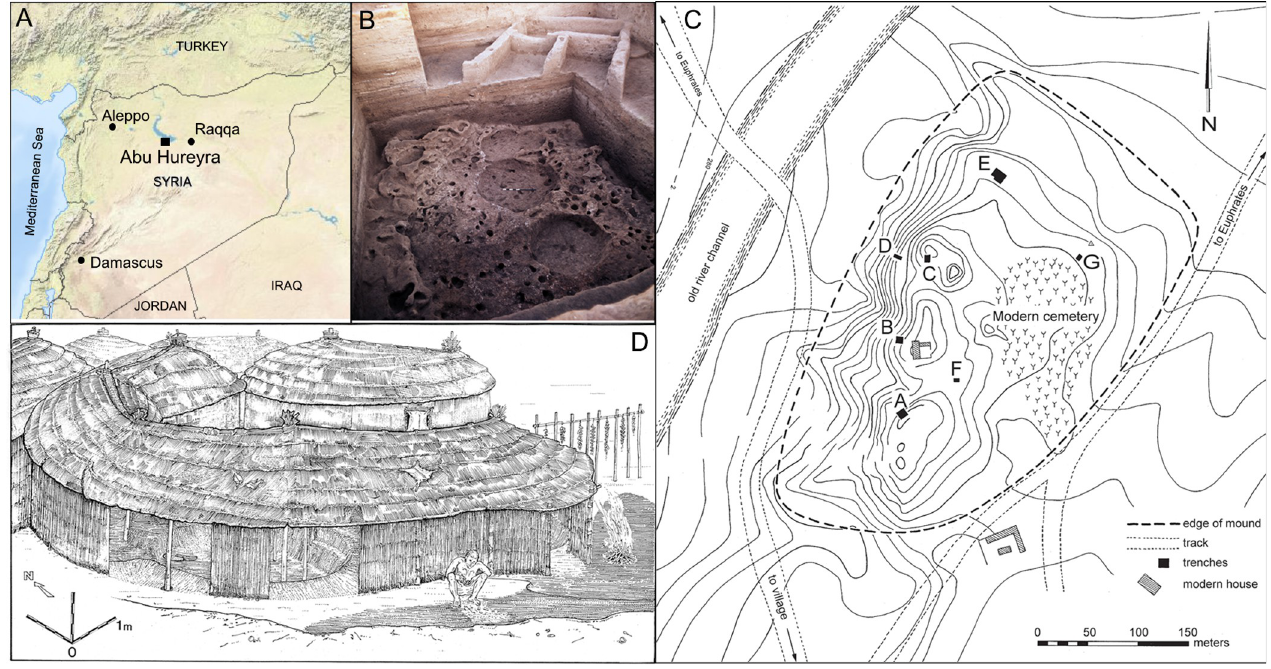
Fig 1. A) Map of Syria highlighting location of Abu Hureyra (base map obtained from USGS National Map Viewer, public domain); B) photograph of superimposed structures within Trench E showing Neolithic 2A rectilinear structure atop Epipalaeolithic 1A pit dwellings in the foreground; C) Plan